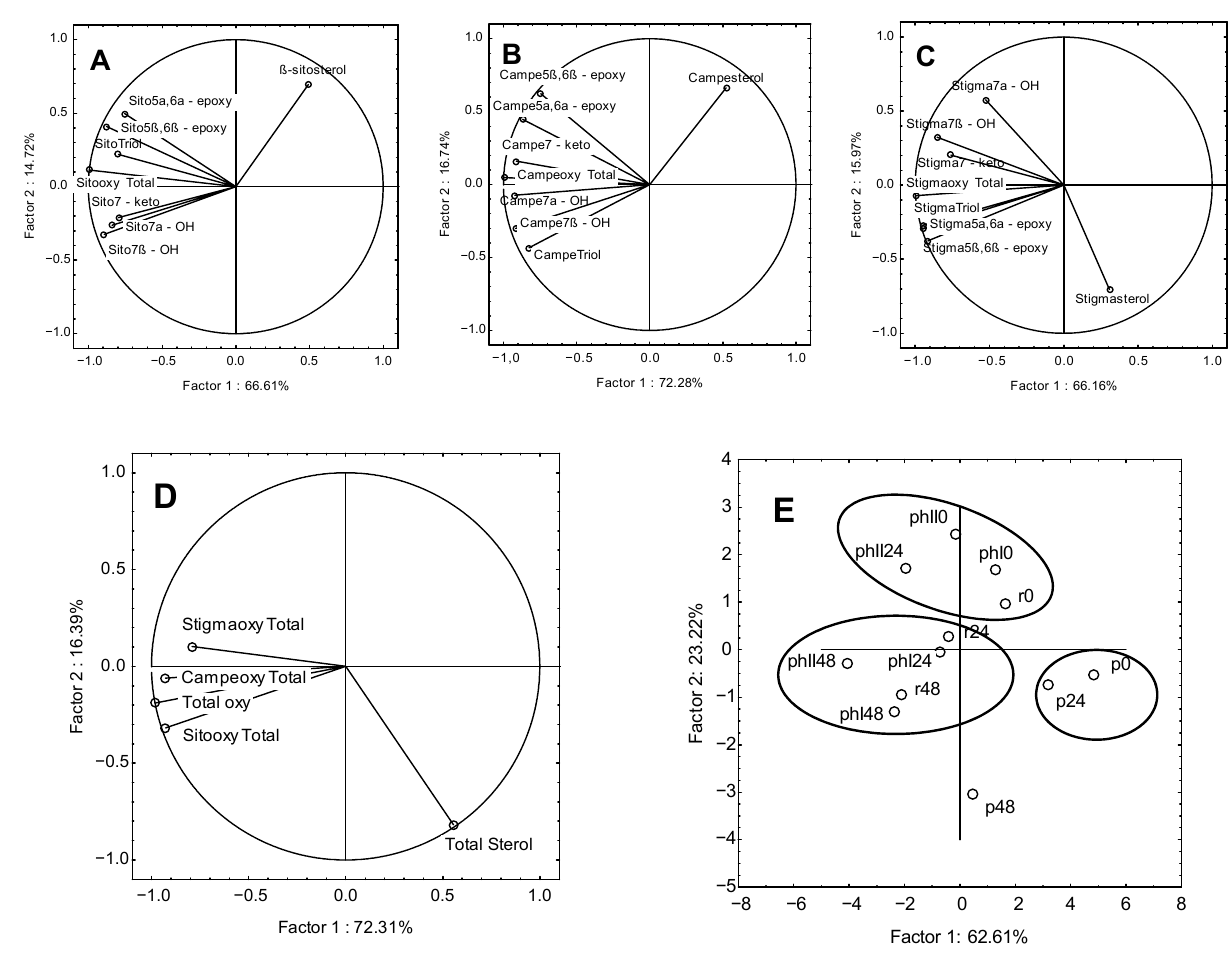
Figure 2. Principal component analysis (PCA) of the loading plot and the score plot of data from ß-sitosterol ( A ), campesterol ( B ), stigmasterol ( C ), and total sum ( D , E ) of oxidation products created during heating rapeseed oil at 170 ◦ C. Names of oil sampes: p—pressed, r—refined, phI—partially hydrogenated IV = 90, phII—Partially hydrogenated IV = 79; 0—unheated oil, 24—oil after 24 h of heating, 48—oil after 48 h of